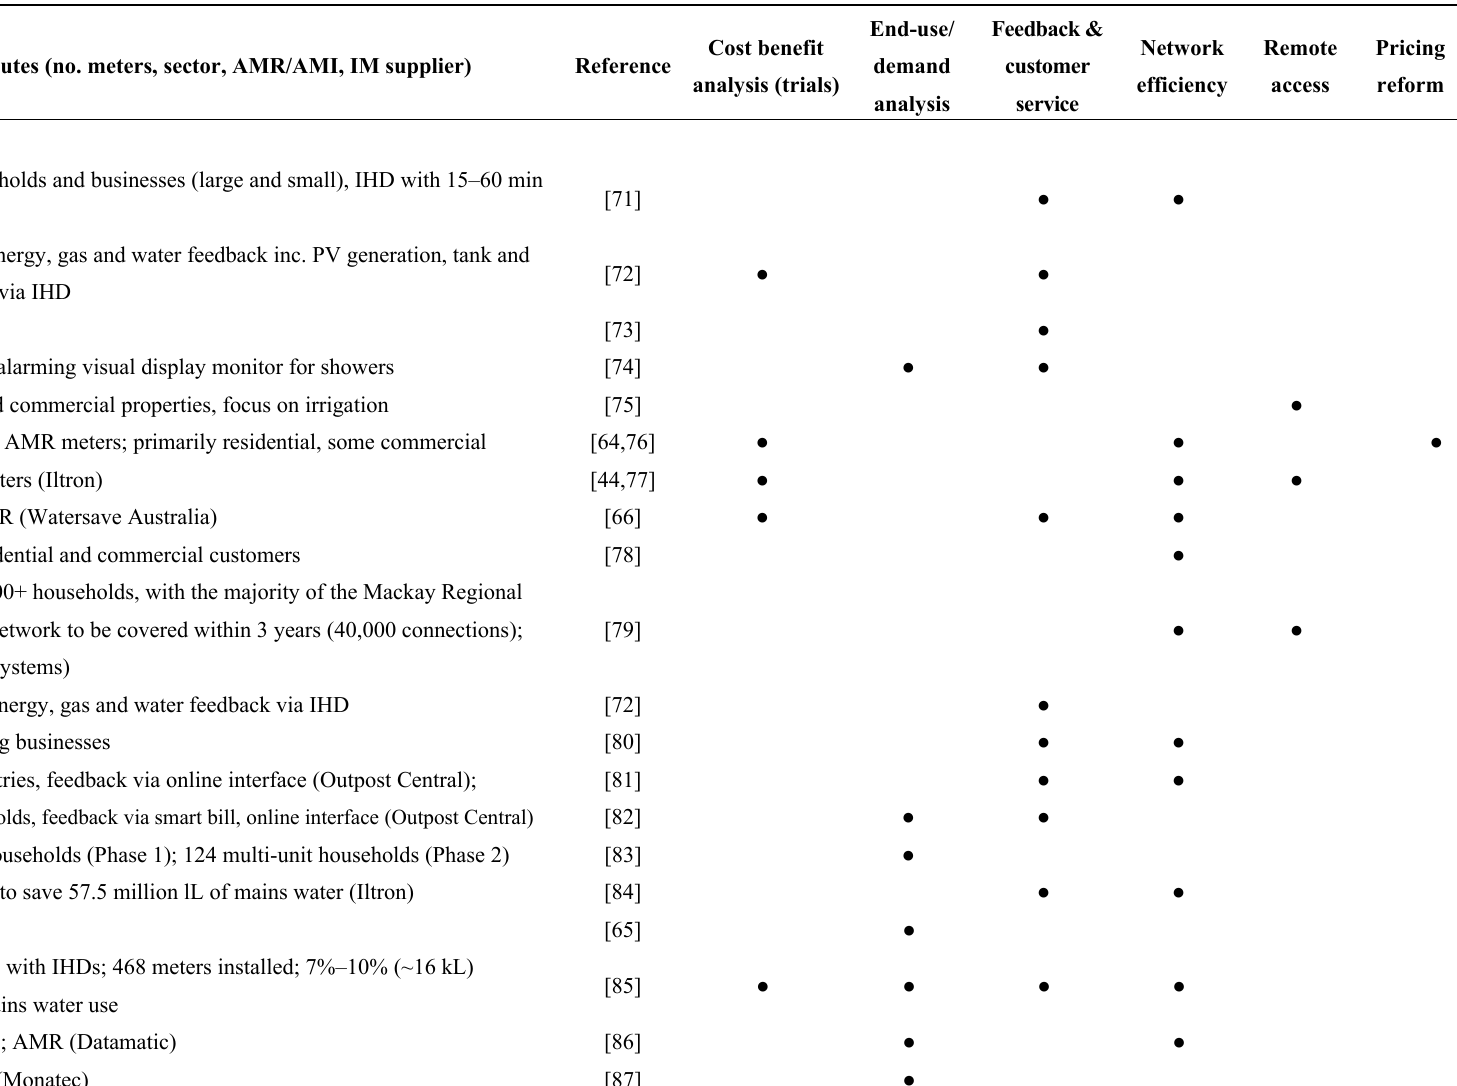
Table 2. Intelligent water metering (IM)